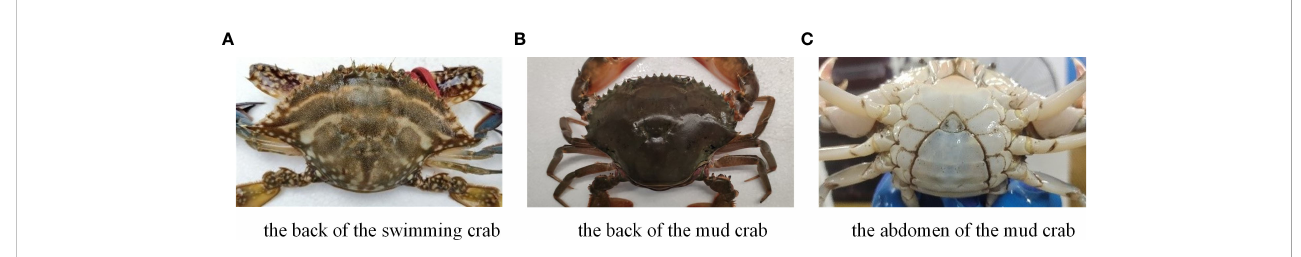
FIGURE 1 Differences between swimming crabs and mud crabs. (A) The back of the swimming crab. (B) The back of the mud crab. (C) The abdomen of the mud